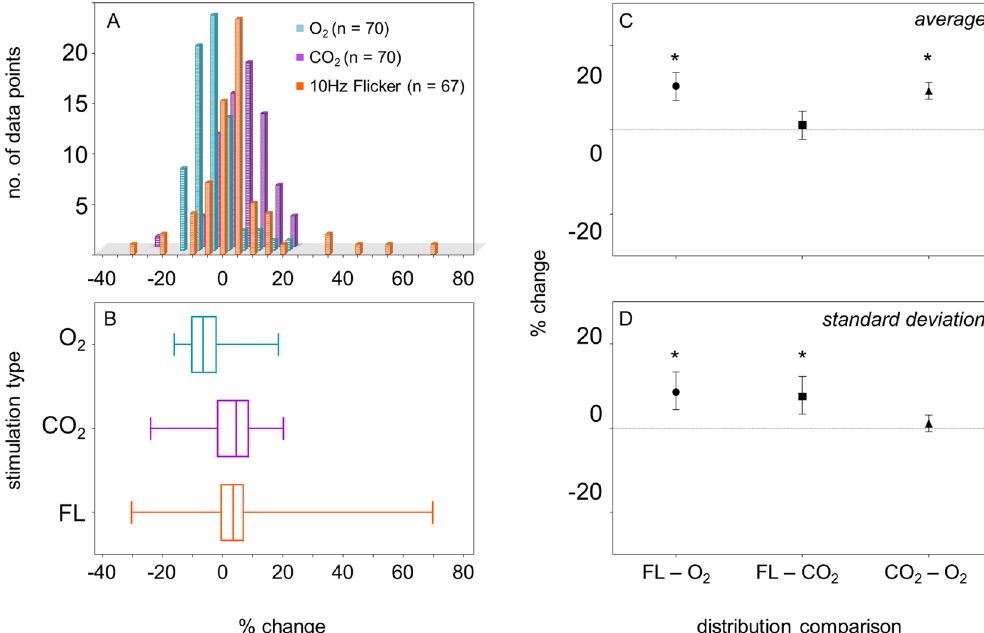
Figure 4. ( A ) Frequency histogram of proportional change for all 70 segments following isocapnic hyperoxia (blue, referenced as O 2 ) or isoxic hypercapnia (purple, referenced as CO 2 ), and for all 67 segments analysed following 10 Hz flicker (orange, referenced as 10 Hz FL). ( B ) Box plot showing the maximum, minimum, median and interquartile range of the distribution for all 70 segments following isocapnic hyperoxia, isoxic hypercapnia and all 67 segments following flicker. ( C ) Difference in mean and ( D ) standard deviation of all possible combinations for flicker (FL), isocapnic hyperoxia (O 2 ) and isoxic hypercapnia (CO 2 ) conditions with bootstrapped 95% confidence intervals. Asterisks denote statistical significance (p <